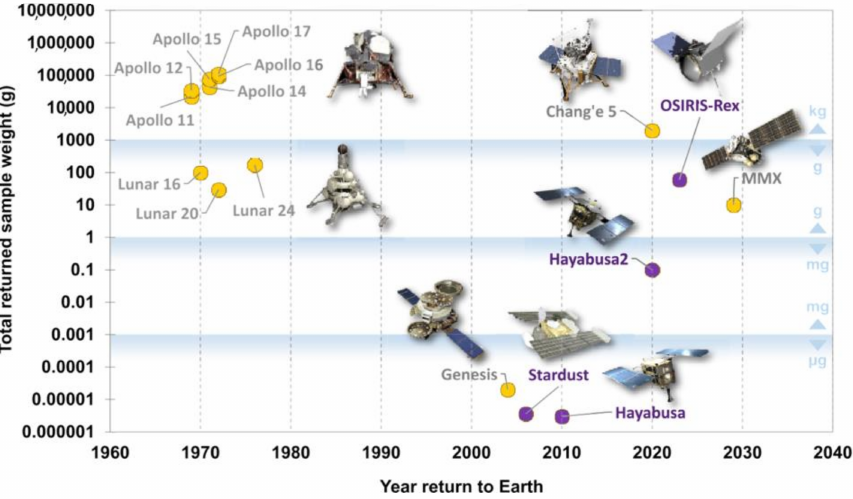
Figure 1. Sample Return Missions chronology in history [13] (image credit: NASA, JAXA,